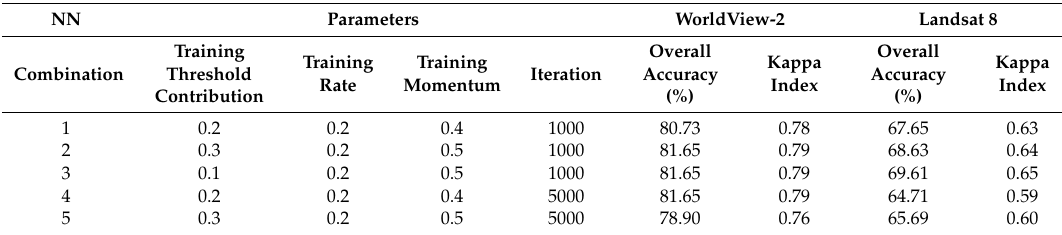
Table 7. Overall accuracy and Kappa index classification of